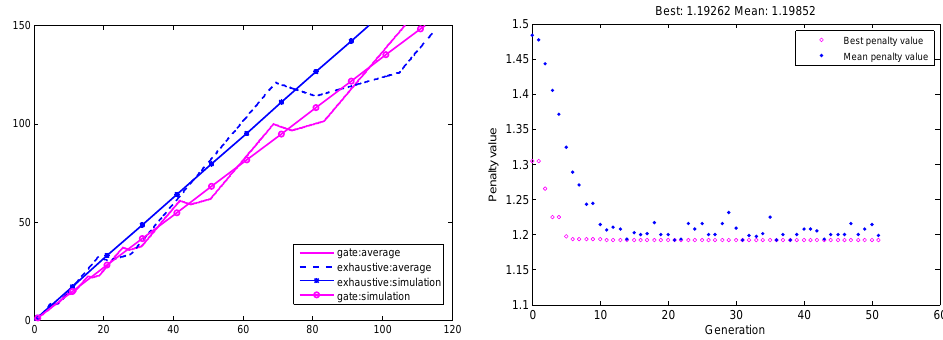
Figure 5: Left: the fluid limit of the scaled total queue length process (exhaustive and gated). Right: the convergence process of the optimal average growth rate by GA